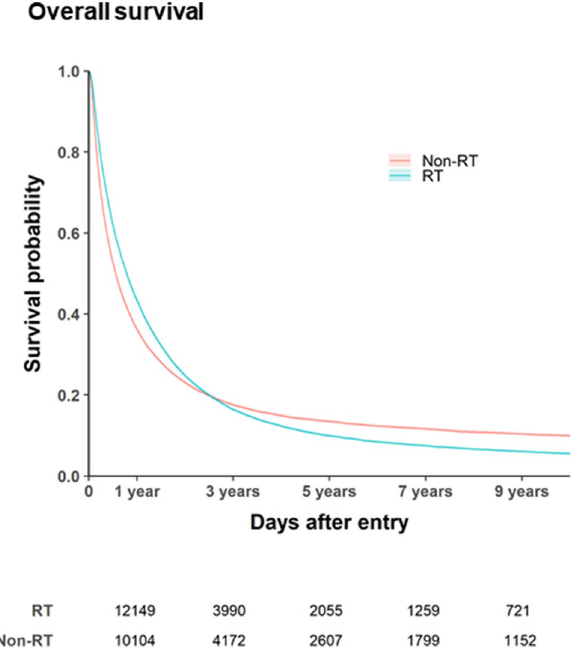
Figure 2. Kaplan–Meier survival curves according to radiotherapy (RT) status. Outcomes are shown as overall survival among all patients. Non-RT Non- radiotherapy, RT radiotherapy. Created using SAS software